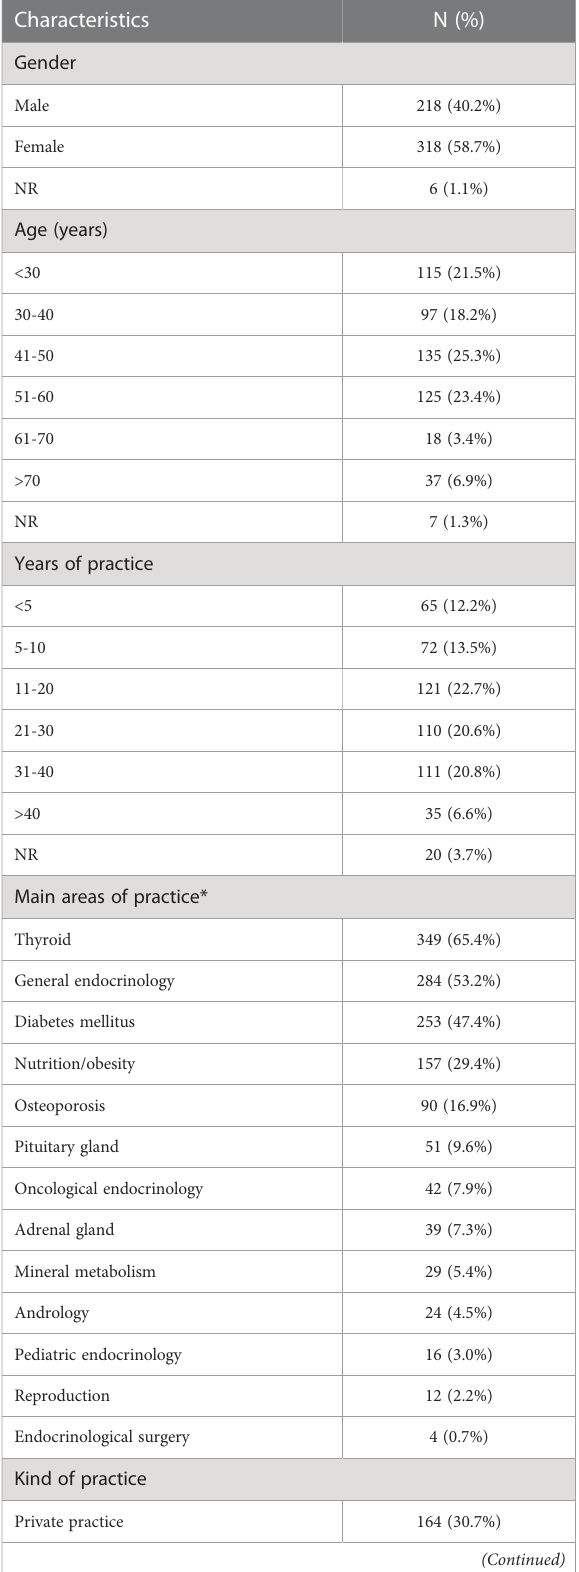
TABLE 1 Characteristics of